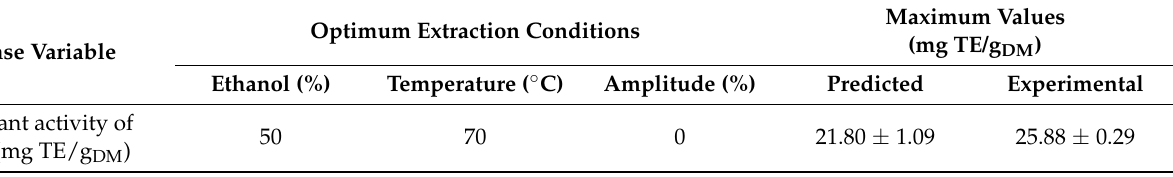
Table 4. Optimal extraction conditions and validation of the experimental and predicted antioxidant activity obtained under the same conditions.